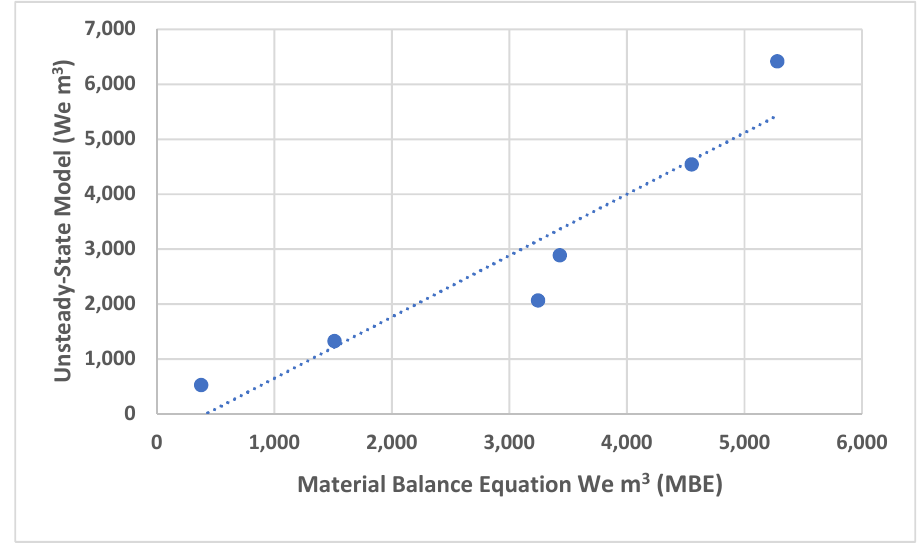
Figure 8. Unsteady ‐ state model versus MBE for Hummar formation. Figure 8. Unsteady-state model versus MBE for Hummar formation.